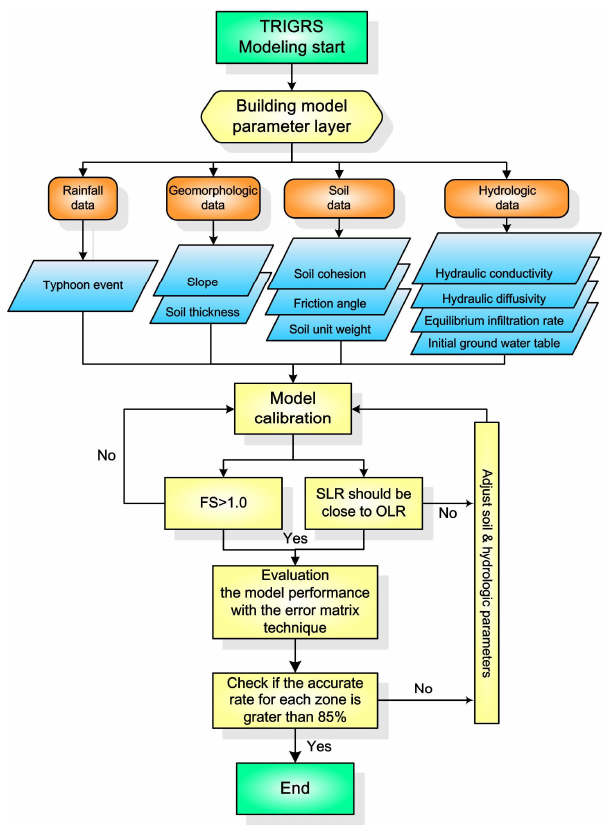
Figure 5. Flowchart for model calibration 607 Fig. 5. Flowchart for model